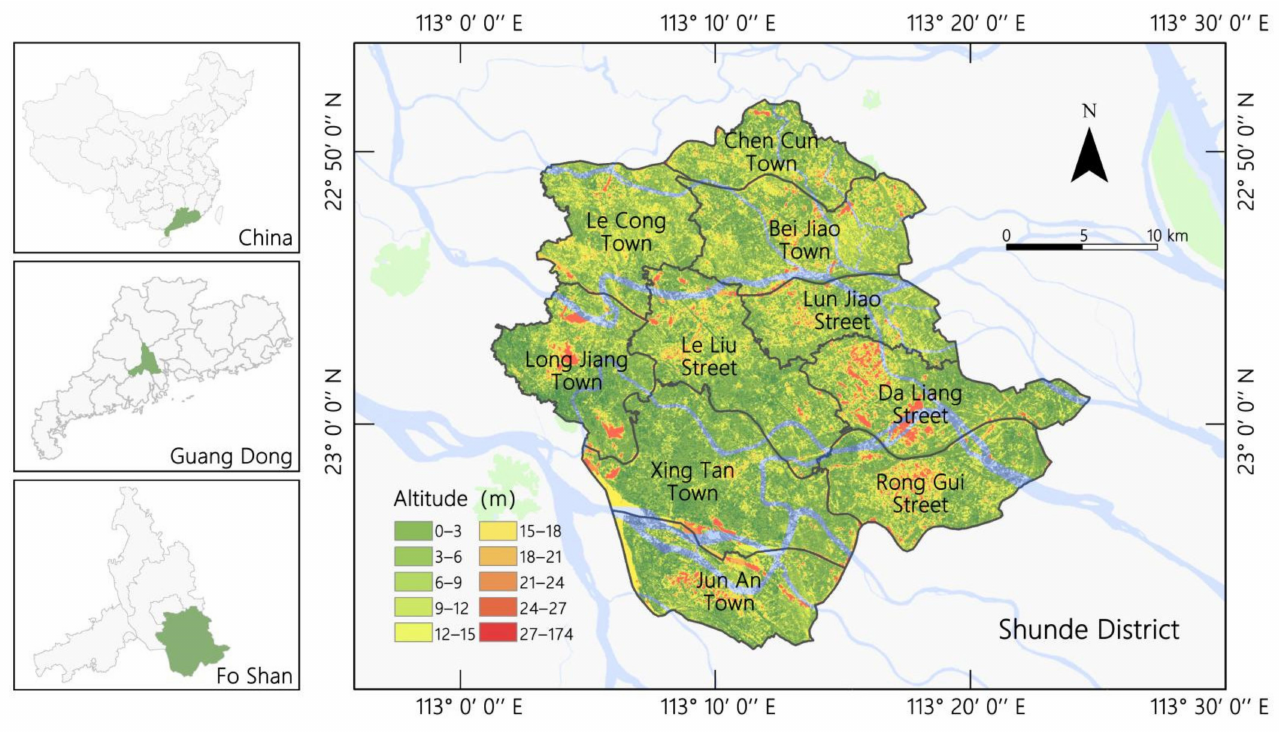
Figure 1. Location of the study area. Table 1. Remote sensing image